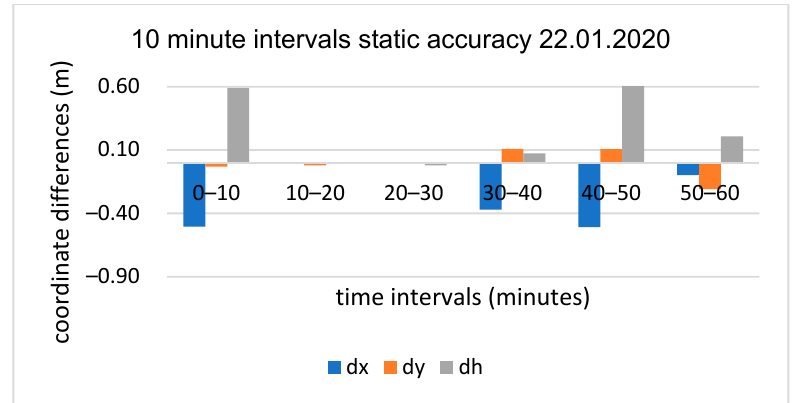
Figure 11. 10 min sub-session positioning results for the second test, baseline OPNT–P30Pro (4 km). Appl. Sci. 2020 , 10 , x FOR PEER REVIEW